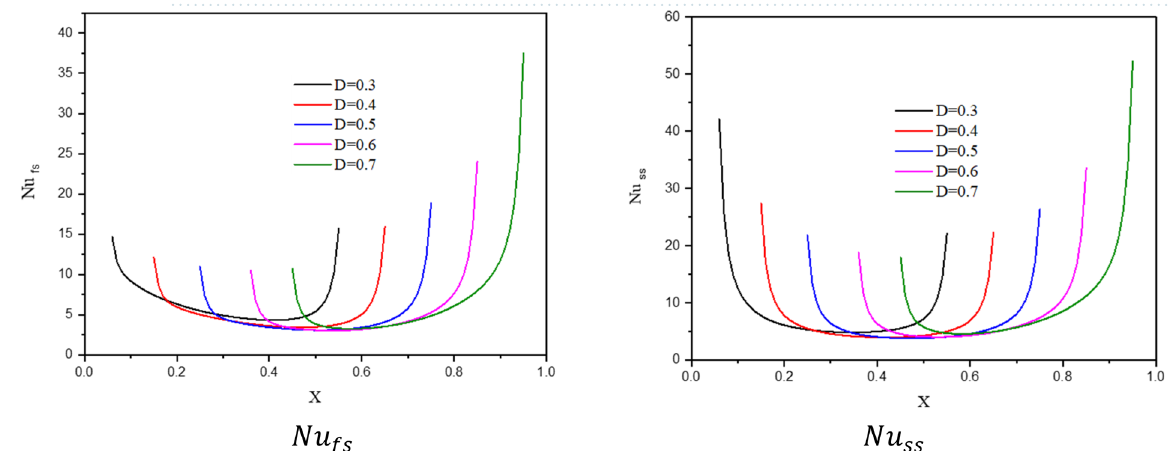
Figure 23. Profiles of Nu fs and Nu ss along the heat source below the changes on a heat source position D for a hybrid nanofluid at φ Cu k r = 1, ε = 0.5, k fs = 1, Da = 10 − 3 , H ∗ = 10, Ha =